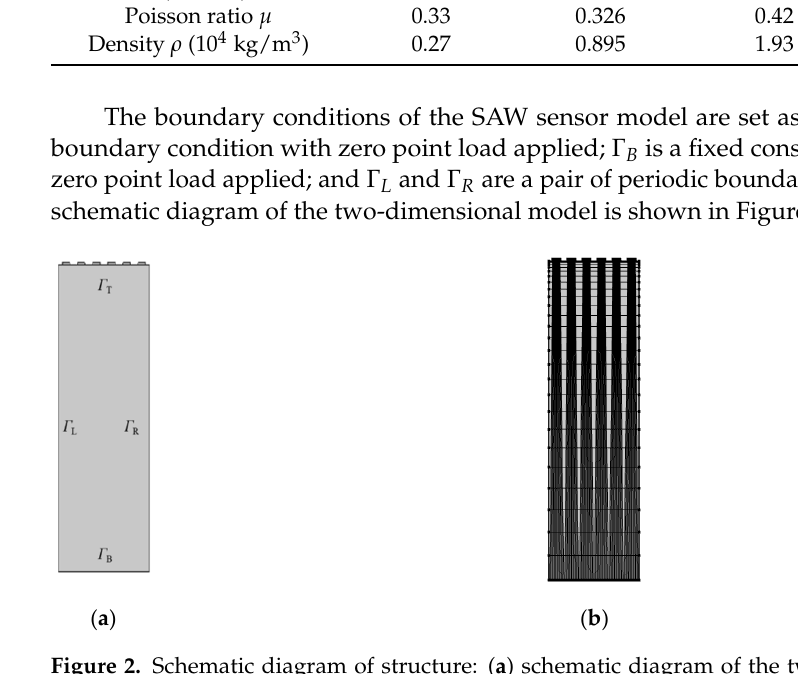
Table 2. Material parameters of electrodes.